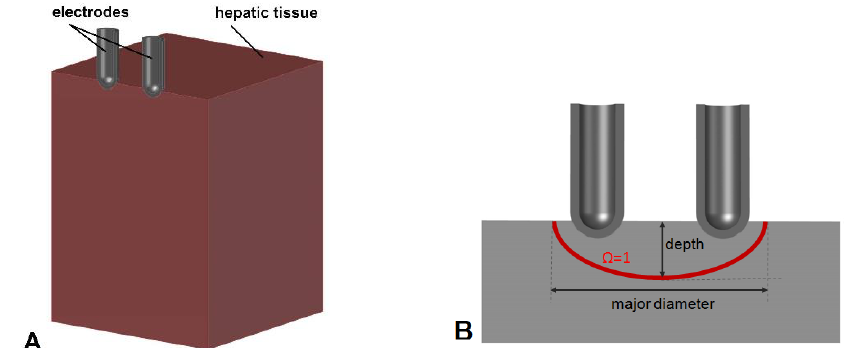
Figure 3. A : Geometry and materials used in the study. B : Scheme of the intermediate space between the two applicator tips where the coagulation zone (CZ) (curve Ω = 1) was expected. CZ depth was measured on the middle plane between the tips. CZ diameter was the longest distance between two points on a parallel plane to the upper tissue surface. Figures out of scale.